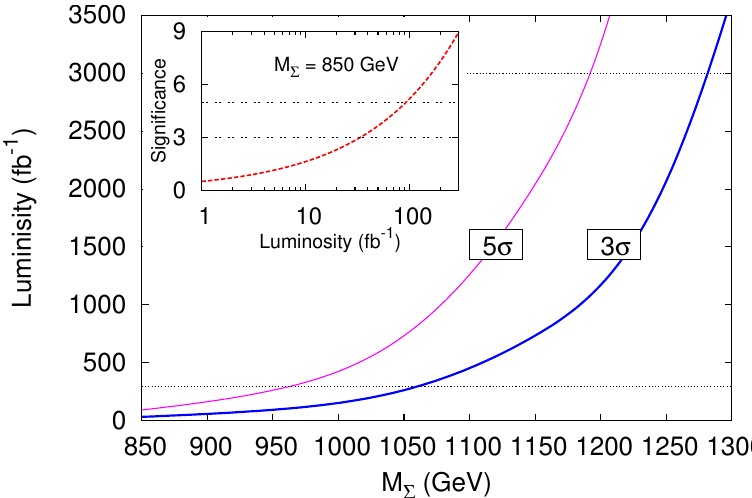
Figure 5 . Projection of 3 (cid:27) (blue) and 5 (cid:27) (magenta) signi(cid:12)cance contours as a function of HSCP mass and integrated luminosity for the Type III seesaw with a sterile neutrino. Inset depicts the signi(cid:12)cance of BP1 with integrated luminosity during 14 TeV runs of LHC.